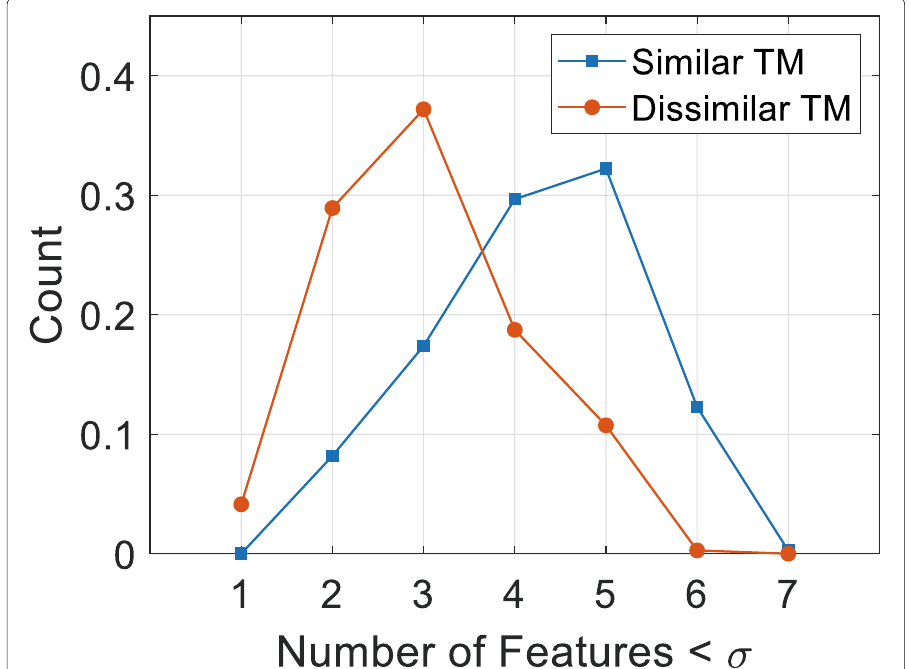
Fig. 3 Statistics of the number of features whose distance is less than the standard